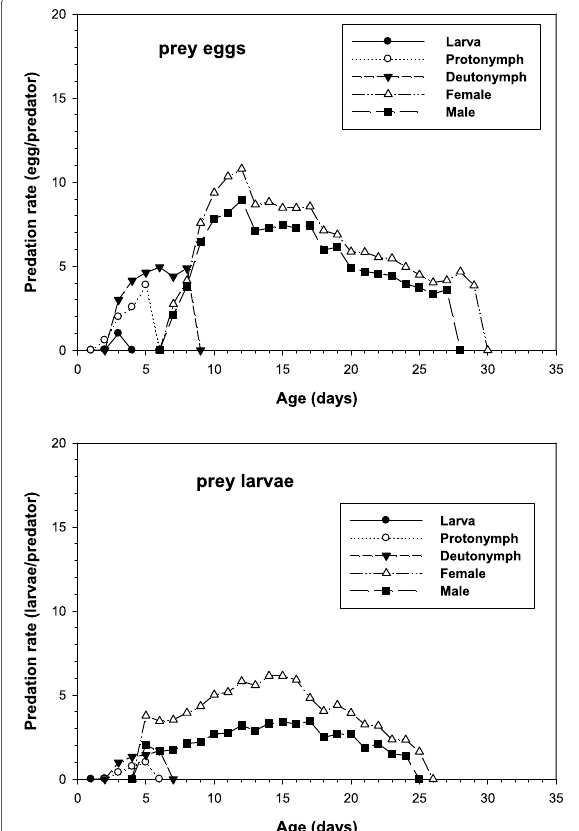
Fig. 5 Age-stage predation rate ( Cxj ) of Blattisocius mali on eggs and larvae of Tyrophagus